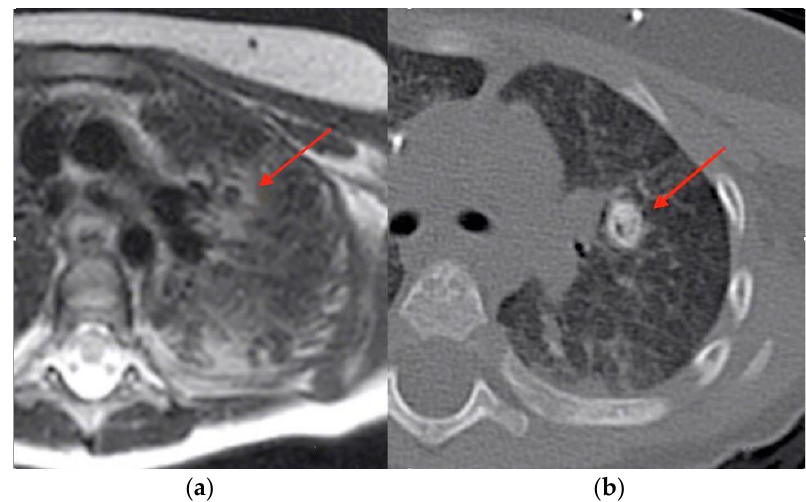
Figure 1. ( a ) MRI showing the presence of an unclear pulmonary lesion (indicated with the arrow); ( b ) CT scan distinctly showing a pulmonary calcification (indicated with the arrow) which was not clearly seen on MRI.